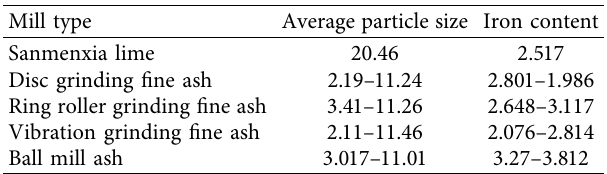
Figure 6: Experimental device structure. Table 4: Iron content